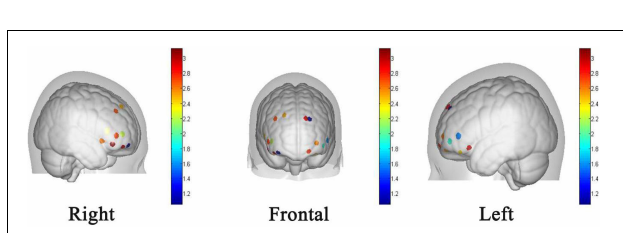
FIGURE 7 | The group level activation t maps derived from the HbO signal. The dots on the brain model indicate the location of the arranged channels, and darker dots indicate higher levels of activation.